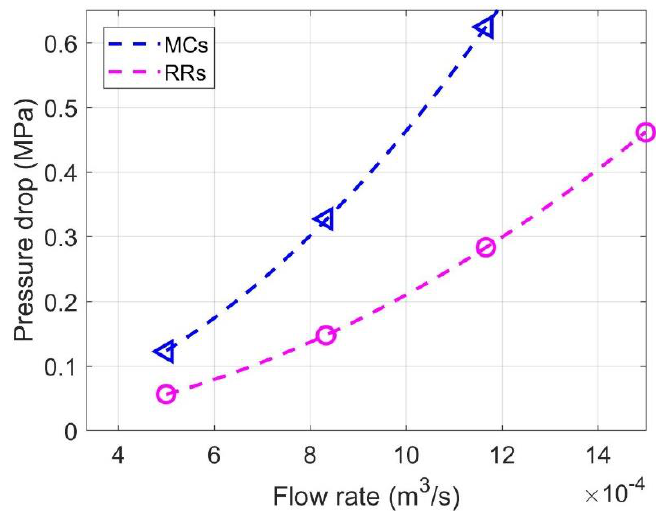
Figure 19. Comparison of the pressure drop computed on a cavity equipped with RR and MCs, at different flow rates.